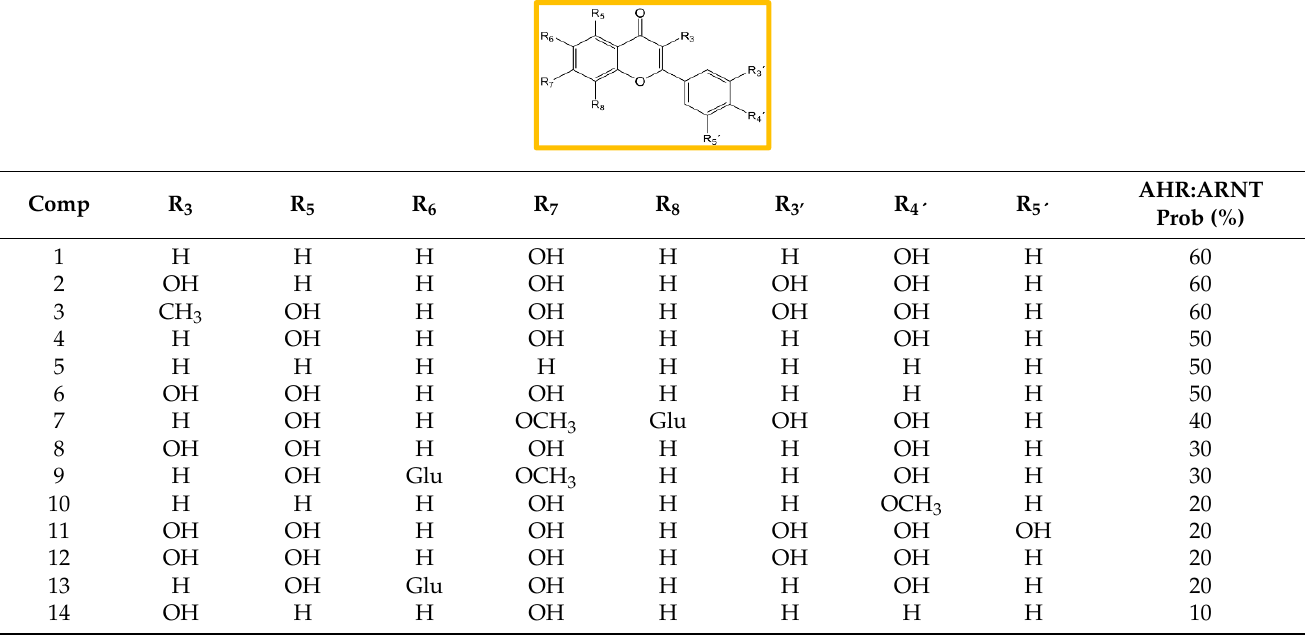
Table 1. Structures of flavones and flavonols active in blocking the formation of the functional heterodimer AHR:ARNT. Percentages of probability of the activity estimated by molecular docking.